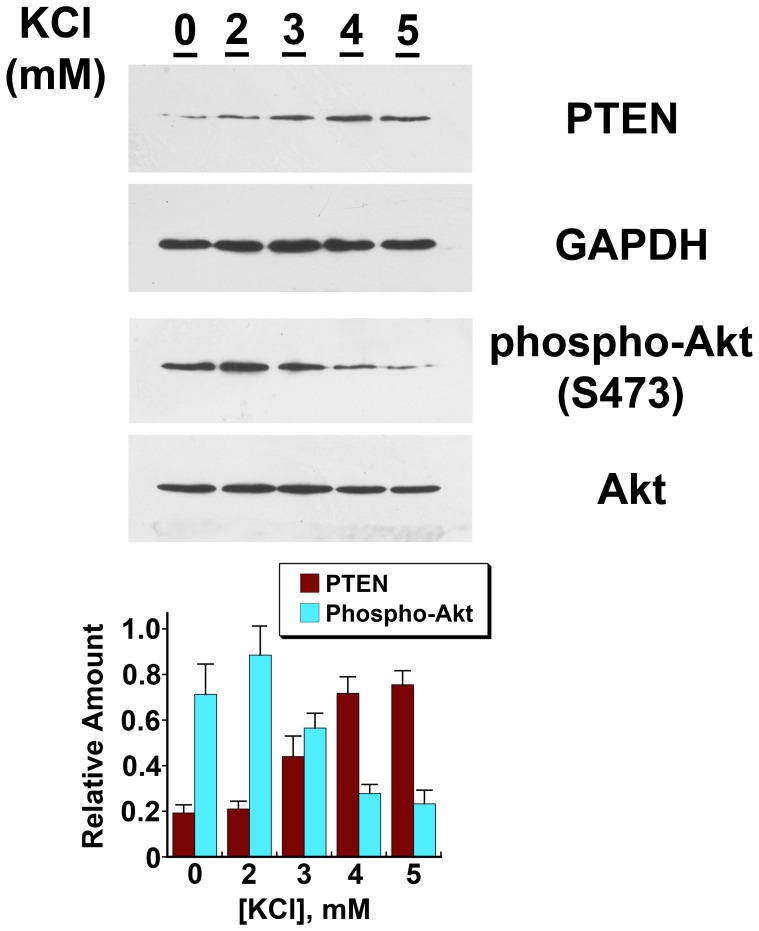
Potassium chloride regulates PTEN levels and Akt function in endothelial cells in a dose-dependent fashion.The western blot shows the results of a single experiment, while the graph shows the data from a total of four separate experiments. Incubating HUVEC overnight in medium containing increasing amounts of [KCl] resulted in a progressive statistically significant (p-value <0.05) increase in PTEN levels and an associated decline in phospho-Akt(S473). For both PTEN and phospho-Akt(S473), data from cells incubated in [KCl], 0 and 2 mM, differed (p-value <0.05) from data derived from cells incubated in [KCl], 4 and 5 mM.